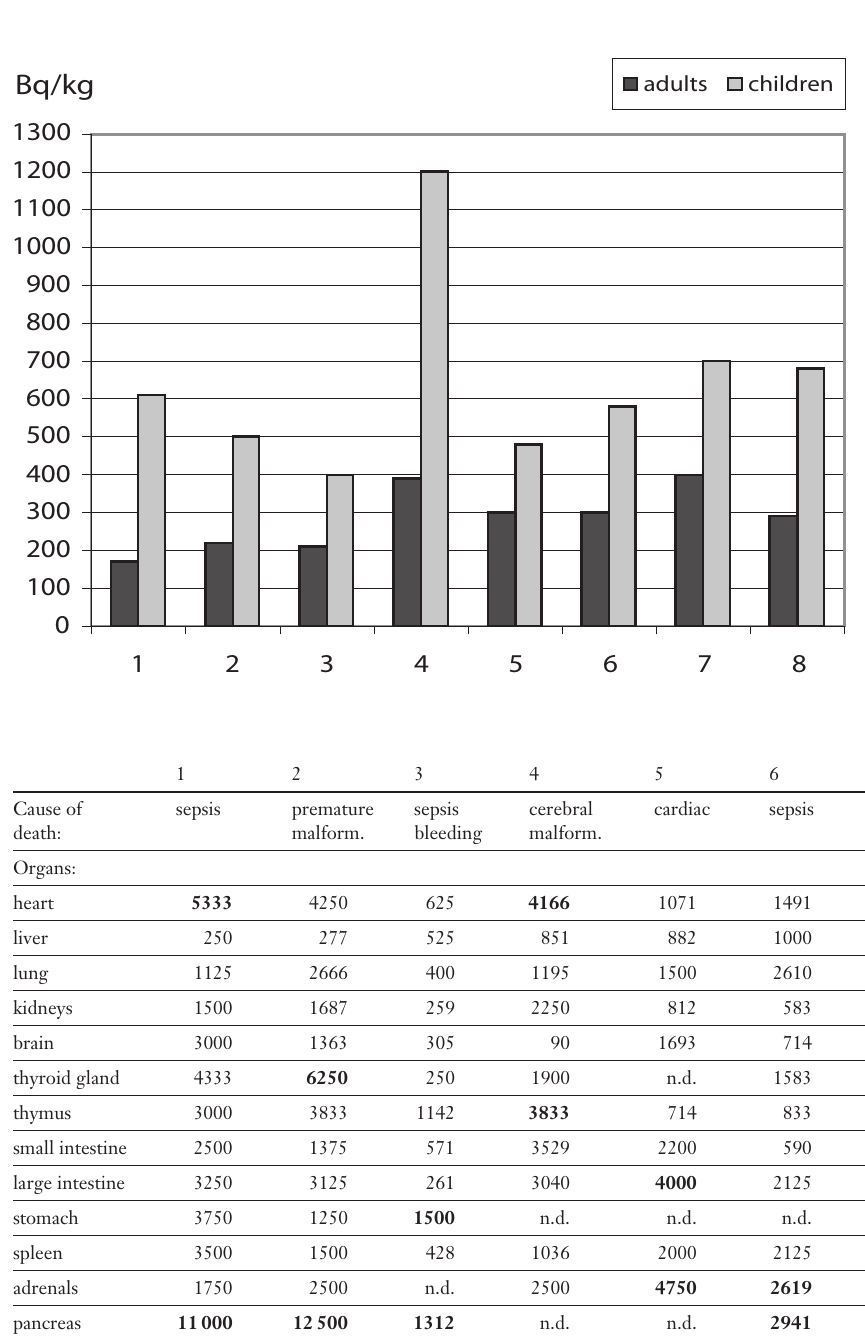
Cs-137 level mea- sured in 13 organs of 6 infants. Very high specific activity of Cs-137 is found in pancreas, adrenals, heart, but also thy- mus, stomach and in- testinal wall. In cases 1 and 2 the concen- tration of Cs-137 in the pancreas is re- spectively 44 and 45 times that in the liver.